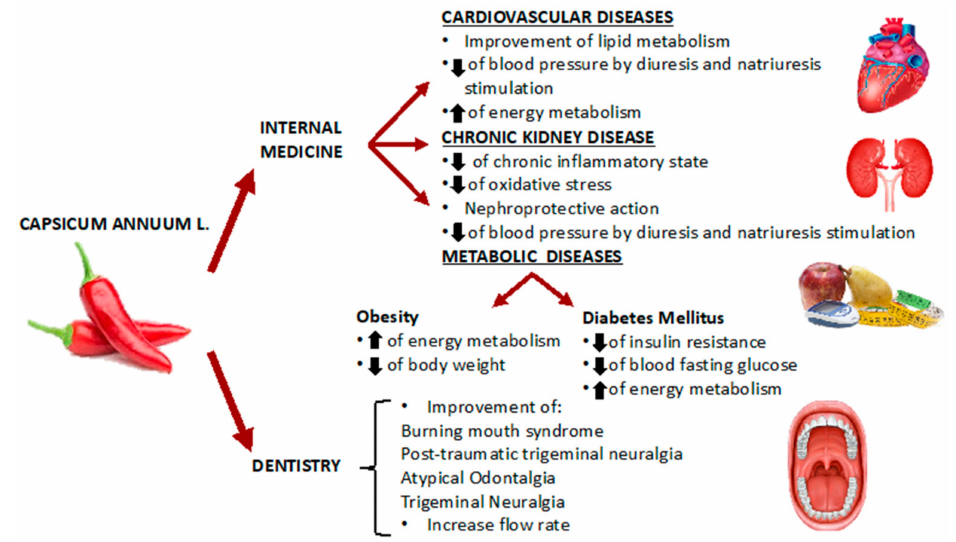
Figure 2. Capsicum annuum L. and its potential use in internal medicine and in